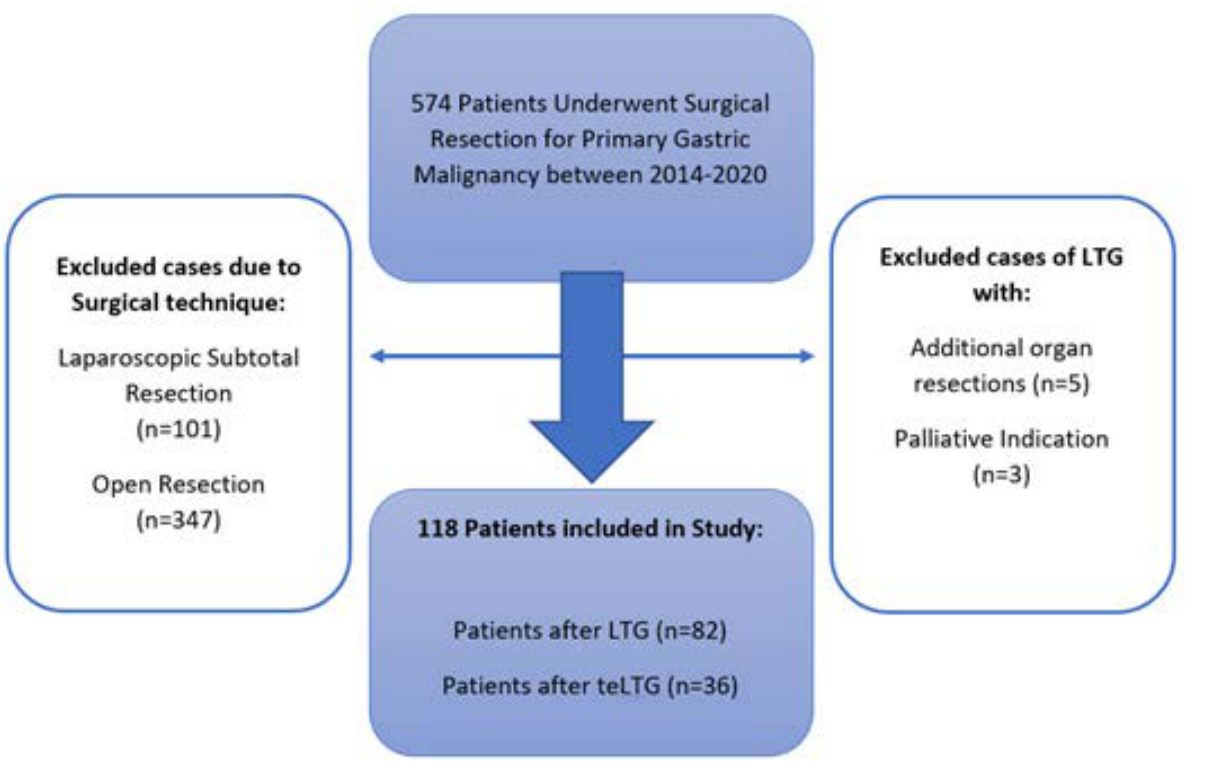
Figure 1. Study exclusion criteria flow